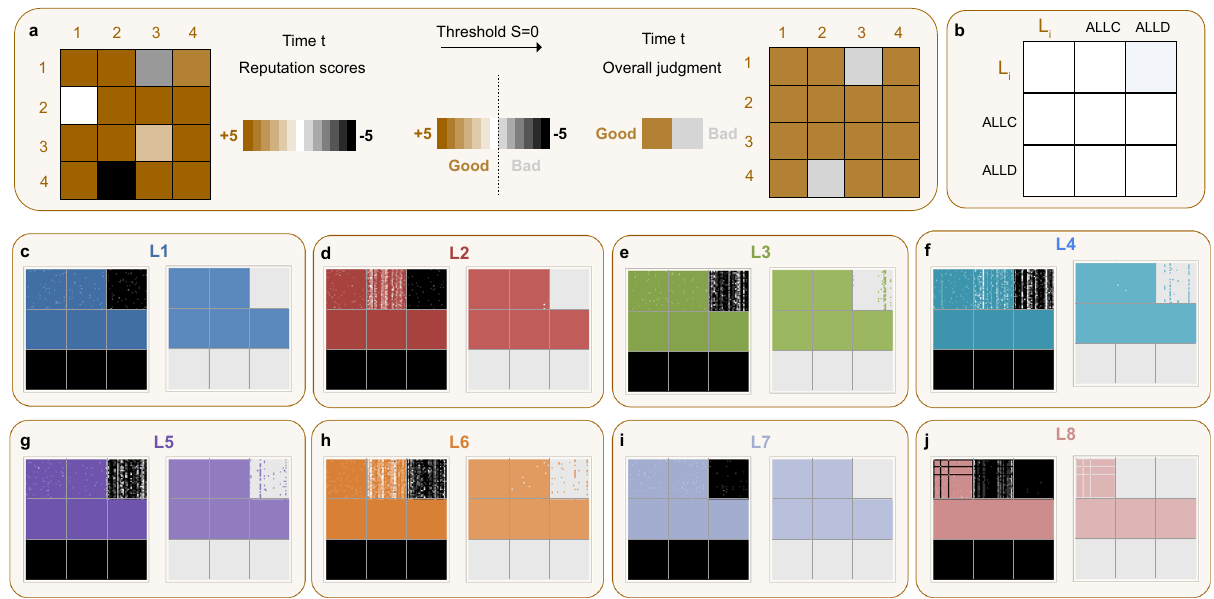
Fig. 2 | Quantitative assessment and reputation dynamics. a Image matrices represent how players assess each other at any given time. We assume that every player keeps track of each population member ’ s reputation score, with scores in the interval [ − 5,+5]. To depict these image matrices graphically, we use colored dots, with the intensity of the color corresponding to the score: for example, a whitedotmeansthatthecorrespondingrowplayerattributesascoreof r =0tothe corresponding column player (left side). On the other hand, players also make an overall judgment of others, in order to be able to use their assessment and action rules. To do so, they compare the scores to a threshold S =0, resulting in a binary labeling of “ good ” and “ bad ” . To visualize this second, less re fi ned layer of the reputationdynamics, we use amatrixwith colored and graydots (right side). b We show image matrices when players either use a leading eight social norm L i , ALLC ,